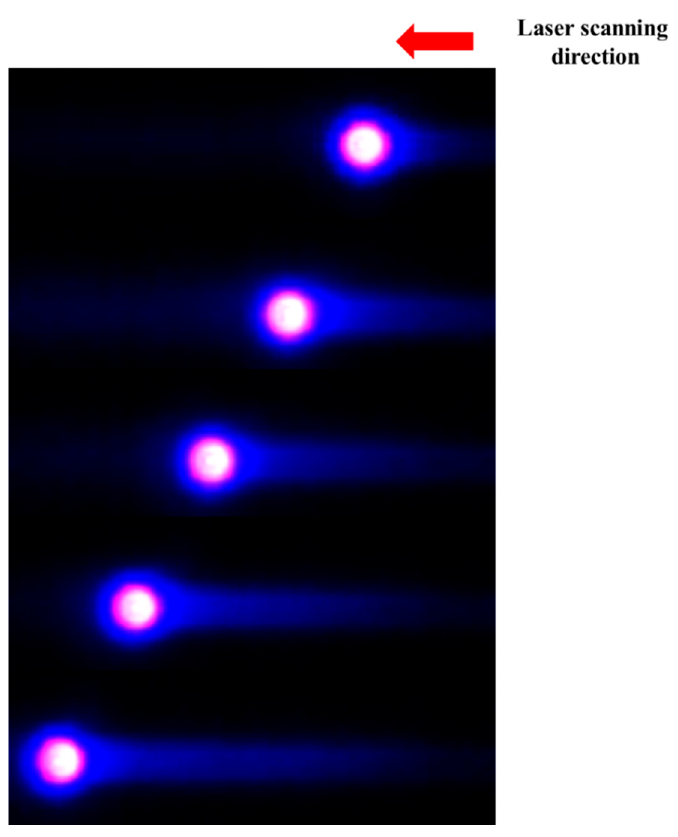
Figure 10. Heat distribution measurement results using an IR camera during laser scan processing.